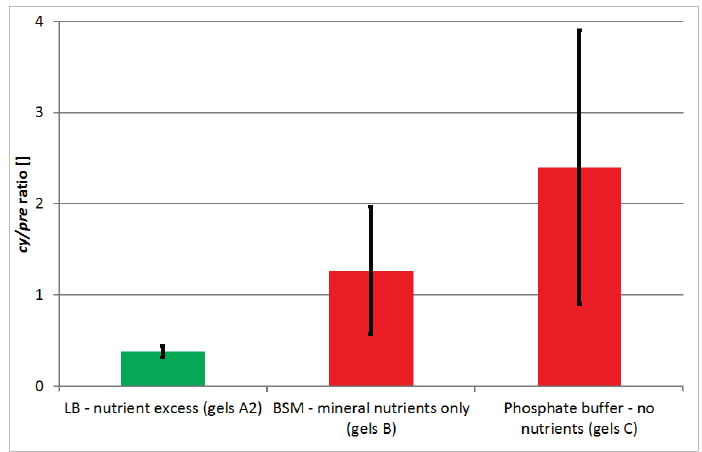
Figure 2. Values of cy/pre indicator as a function of three different media used for suspension of encapsulated P. denitrificans determined at day 1 after encapsulation. Color indicates significant differences based on pair comparisons (t-test, α = 0.05). Error bars show 95%-confidence